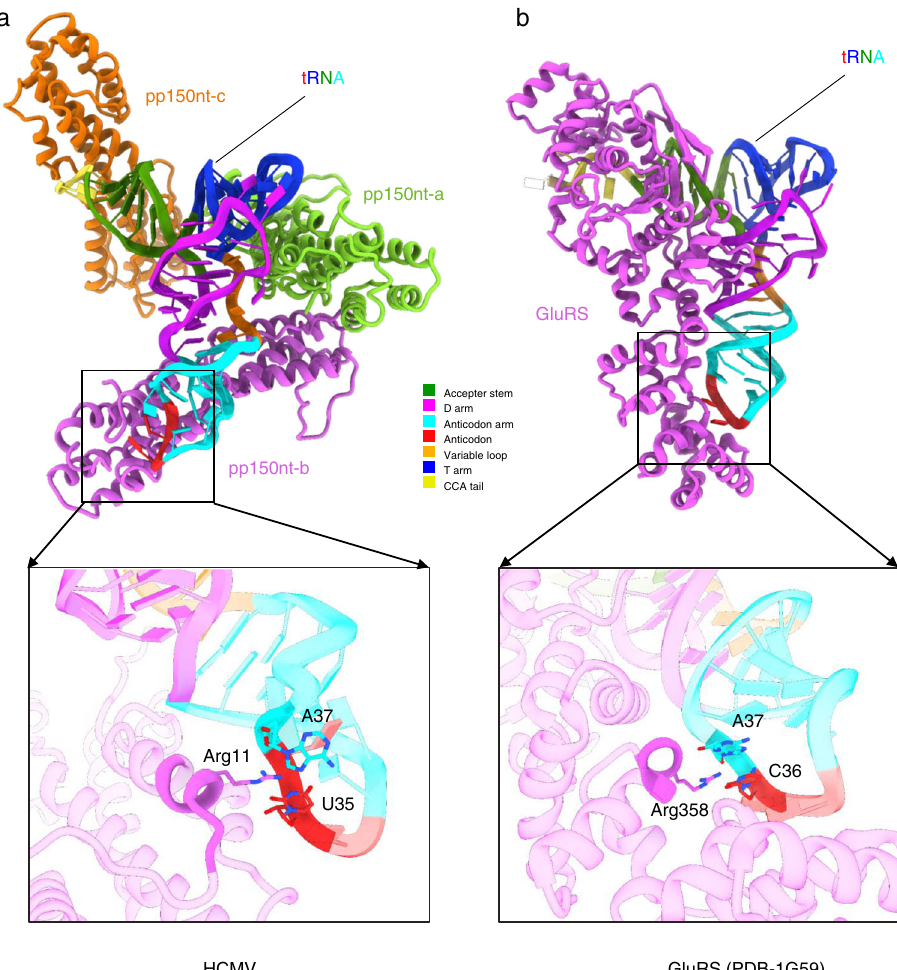
Fig. 3 Comparison between the pp150 and glutamyl-tRNA synthetase (GluRS) on their interactions with tRNA anticodon. a Atomic model of tRNA and its three interacting pp150nts. Inset shows Arg 11 interaction with the anticodon region of tRNA. b Atomic model of GluRS and tRNA. Inset shows Arg358 interaction with anticodon 14